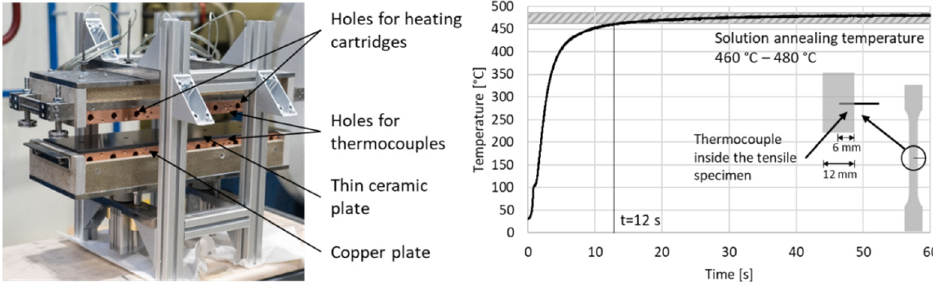
Figure 4. Heating device and heating curve for a tensile specimen.